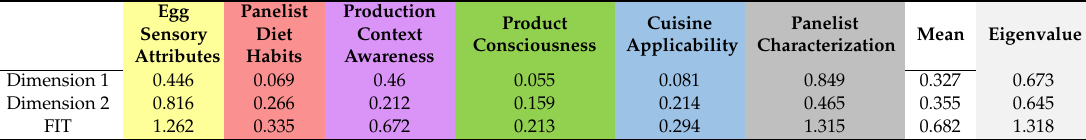
Table 2. Eigenvalues for the two-dimensional solution of nonlinear canonical correlation analysis for Utrerana native hen egg sensory attributes (yellow), panelist diet habits (red), production context awareness (purple), product consciousness (green), cuisine applicability (blue) and panelist characterization (grey) as perceived by cuisine instructed panelists (n =